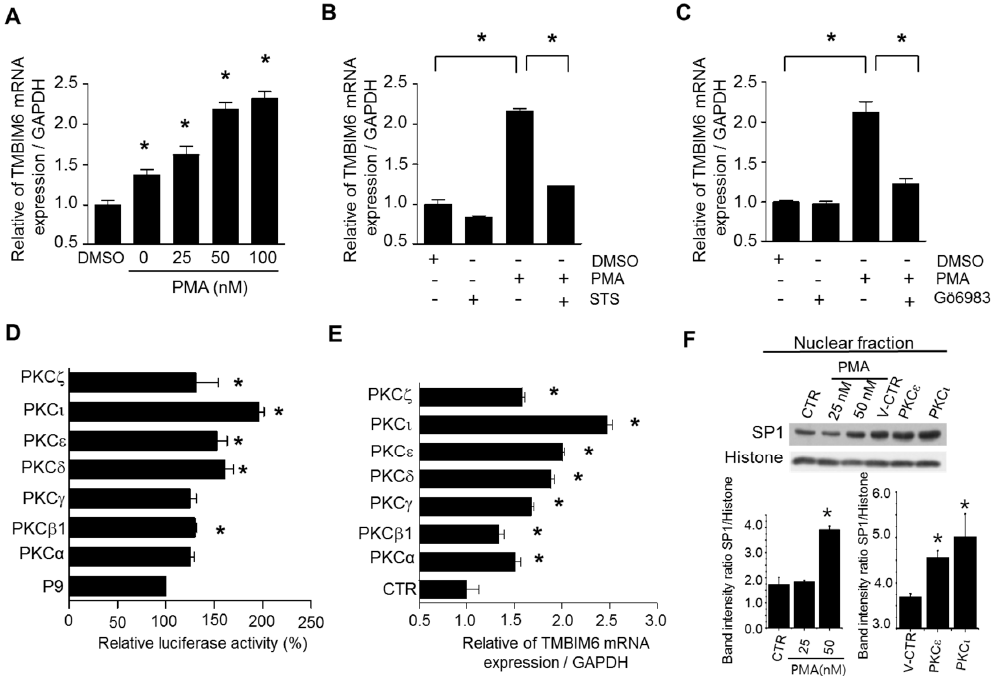
Figure 6. PMA and active PKC isoforms enhances human TMBIM6 gene expression. ( A ) Relative endogenous TMBIM6 mRNA levels after treating HT1080 cells with different concentrations of